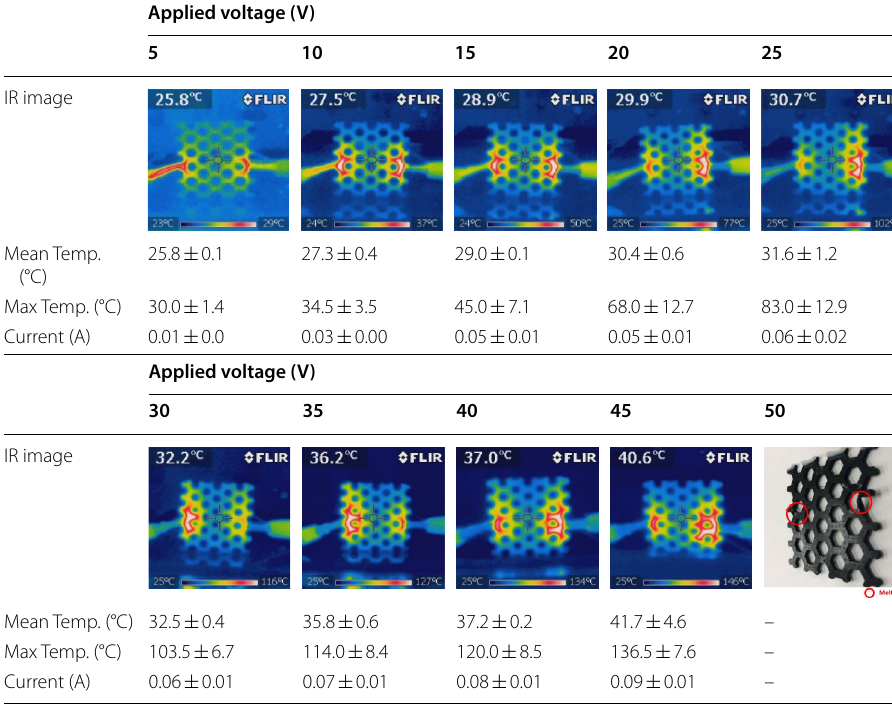
Table 9 IR images of MD carbon black/PLA 3D printed honeycomb samples Applied voltage (V)